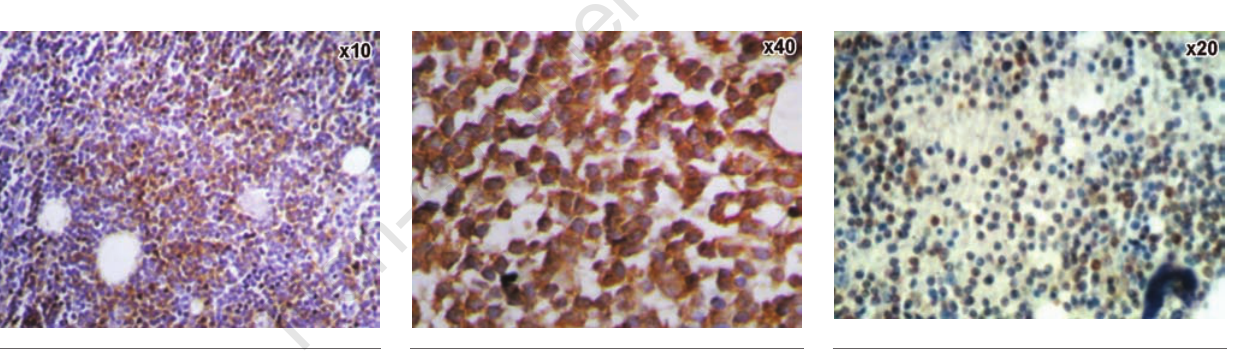
Figure 5. A case of chronic lymphocytic leukemia showing positive CD23.